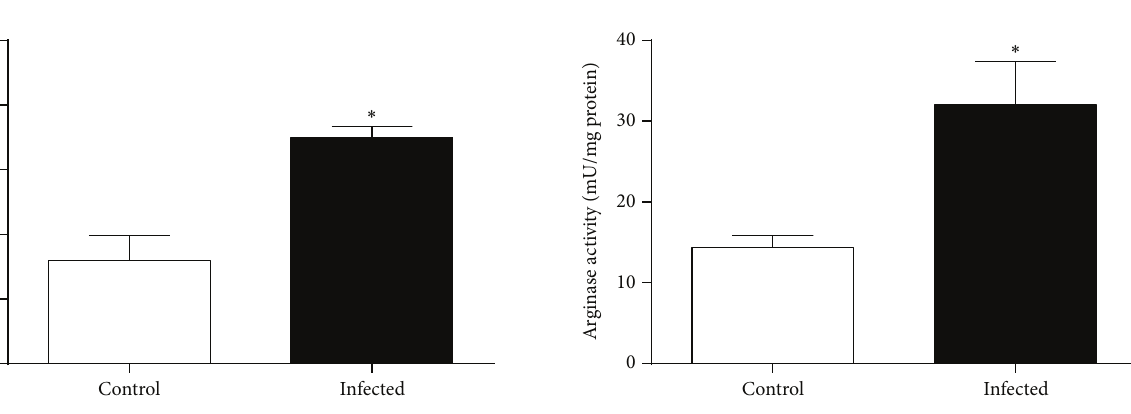
Figure 2: NO metabolite (nitrate+nitrite) concentrations in lung homogenates of mice infected with Pseudomonas aeruginosa and noninfected controls ( 𝑛 = 6 per group). NO metabolite concentra- tions were higher in the infected animals ( ∗ 𝑃 < 0.001 ).